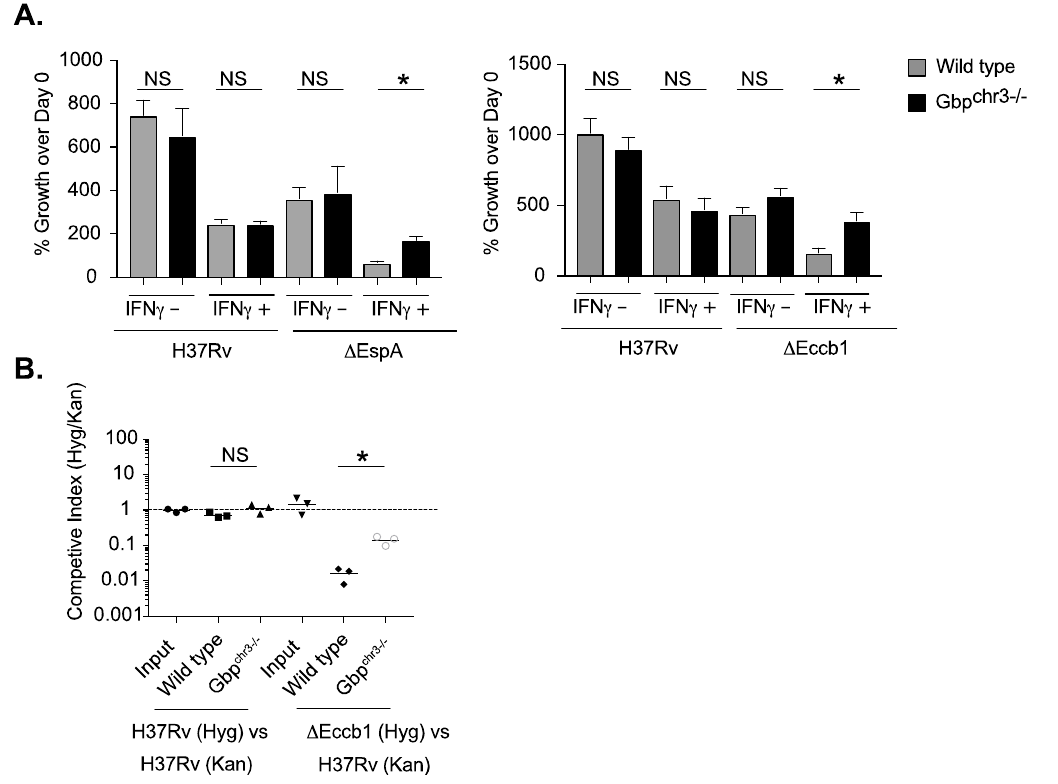
Figure 5. M. tuberculosis ESX1 mutants are susceptible to GBP-mediated control. ( A ) BMDMs from wild type or Gbp chr3 − / − mice were infected with M. tuberculosis H37Rv, ∆ espA (Left) or ∆ eccb1 (Right) for 4 h then washed with fresh media in the presence or absence of IFN γ . Five days later the macrophages were lysed and serial dilutions were plated to quantify colony forming units (CFU) of viable M. tuberculosis . Shown is the mean CFU from four biological replicates ± SD * p < 0.05, NS no significance by two-tailed t-test. Data are representative of two independent experiments with similar results. ( B ) Following low-dose aerosol infection with a 1:1 mixed infection of either H37Rv (Hyg):H37Rv (Kan) or ∆ eccb1 (Hyg): H37Rv (Kan) (day 0 of ~100–200 CFU), total bacteria in the lungs that were either Kan or Hyg resistant were quantified. The competitive index was calculated